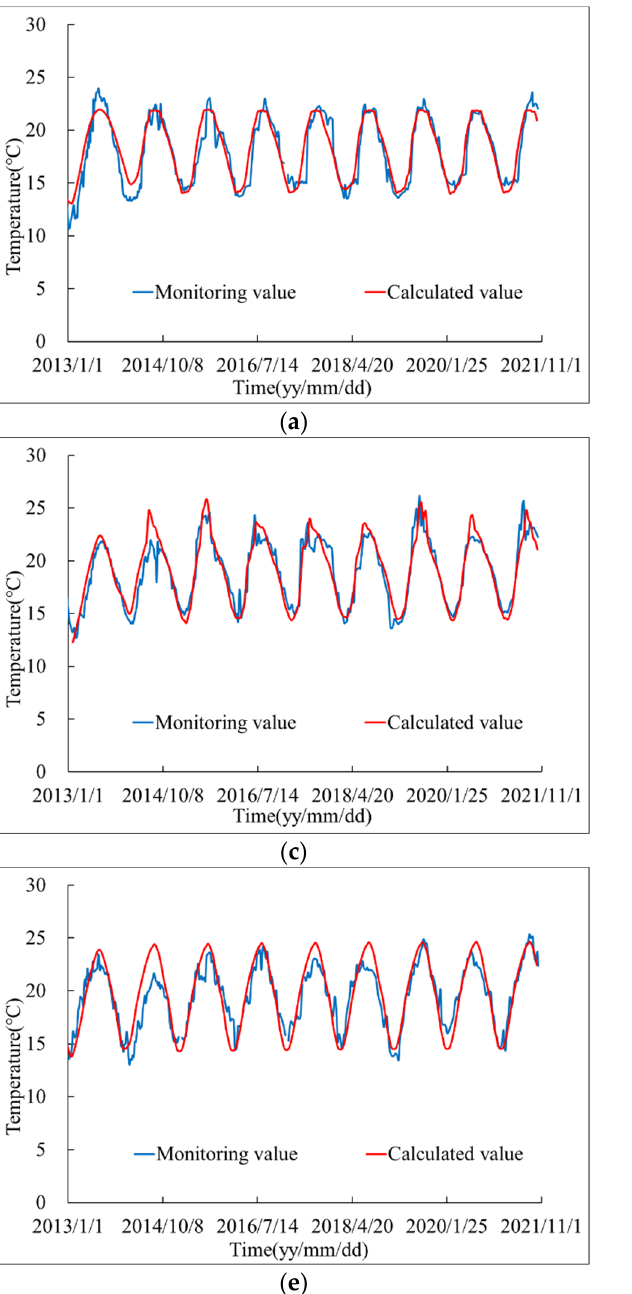
Figure 11. Comparison between measured value and calculated value of temperature at dam surface. ( a ) T16-19; ( b ) T16-23; ( c ) T16-27; ( d ) T16-29; ( e ) T16-14; ( f ) T16-28.